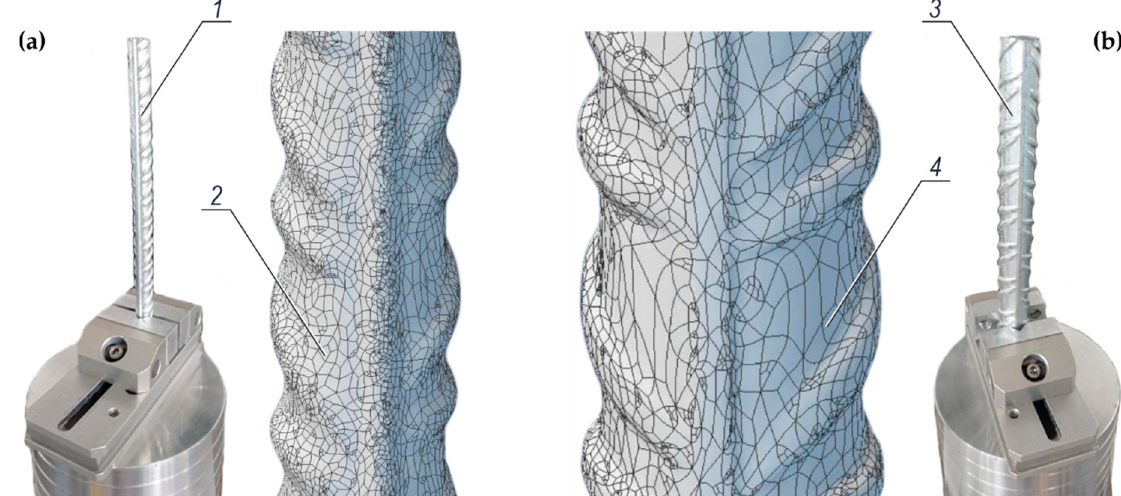
Figure 7. 3D scanning of typical fragments of ribbed rebars made of steel grade B500SP: ( a ) a rebar with a diameter of 8 mm, ( b ) a rebar with a diameter of 16 mm; 1 and 3 —rebars ϕ 8 mm and ϕ 16 mm stabilised prior to 3D scanning, 2 and 4 —represented geometry of rebars ϕ 8 mm and ϕ 16 mm based on point cloud data.